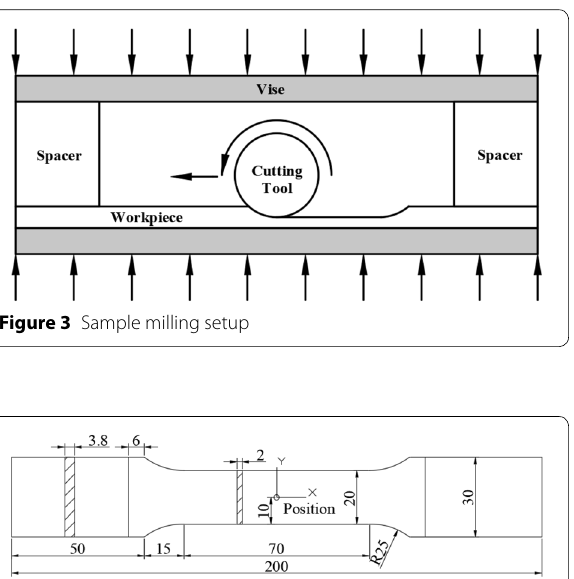
Figure 4 Residual stress measurement point position (unit: mm)